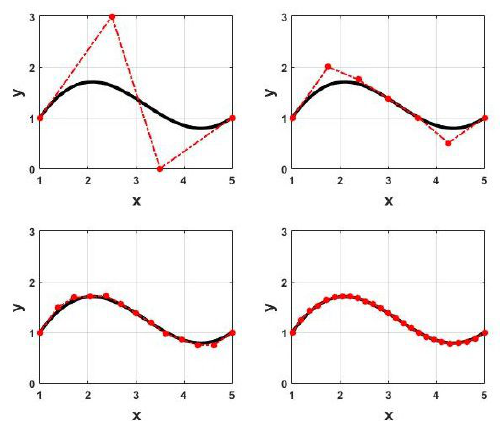
Figure 6. A cubic Bézier curve ( top left ) is subdivided into two Bézier curves of the same degree ( top right ) using the de Casteljau’s algorithm. The control polygon generated by recursive subdivision converges to the original Bézier curve ref. [28]. Copyright 2021 IEEE. Successive refinement of the original control polygon after 2 ( bottom left ) and 3 ( bottom right )